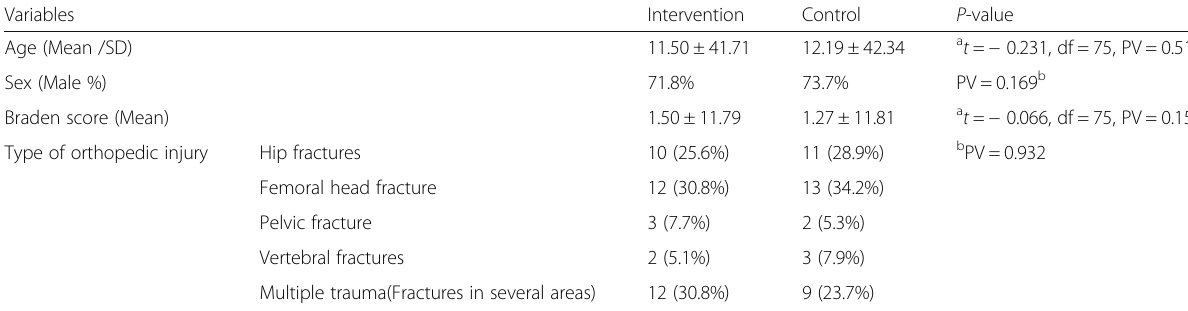
Table 2 Frequency of demographic variables of two groups Variables Intervention